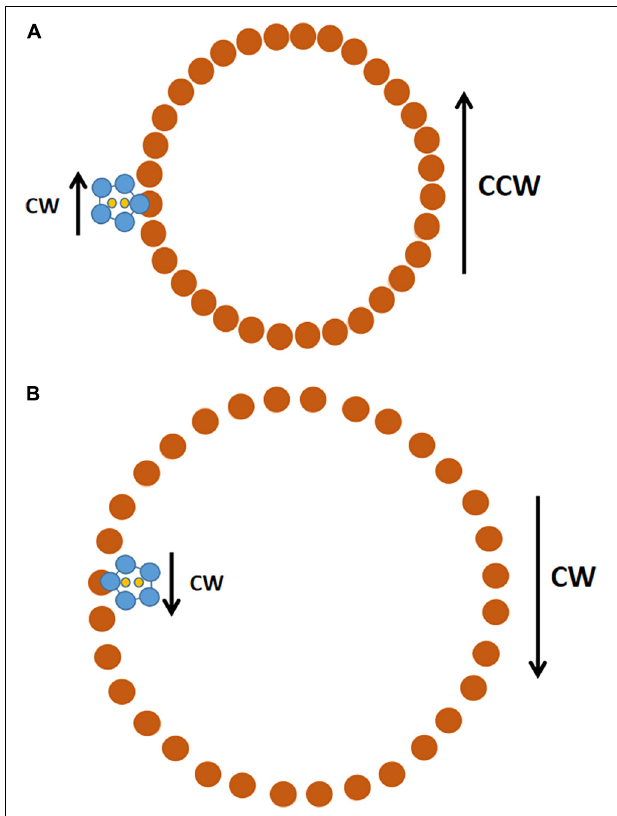
FIGURE 3 | Schematic of how a CW-rotating stator can drive both CCW and CW rotation of the C-ring. The view is looking down from the cell membrane toward the top of the C-ring. (A) The C-ring is in its compact conformation. In the stator unit (MotA pentamer in blue, MotB dimer in yellow), the MotA pentamer rotates CW around the MotB dimer, which is fixed in place by its attachment to the PG cell wall. The inner edge of the MotA ring contacts FliG (brown) in the C-ring and drives its CCW rotation. There are 34 FliG subunits in the C-ring (Hu et al., 2022); the cartoon shows 32 because it was easier to get 32 evenly spaced. (B) The C-ring is in the expanded conformation it assumes after binding of CheY-P to FliMN. The stator unit remains fixed in the same position, but now, when the MotA pentamer rotates CW, its outer edge makes contact with FliG and drives rotation of the C-ring in the CW direction. Only one stator unit is shown, but there is room for up to 11 stators to associate with the C-ring.